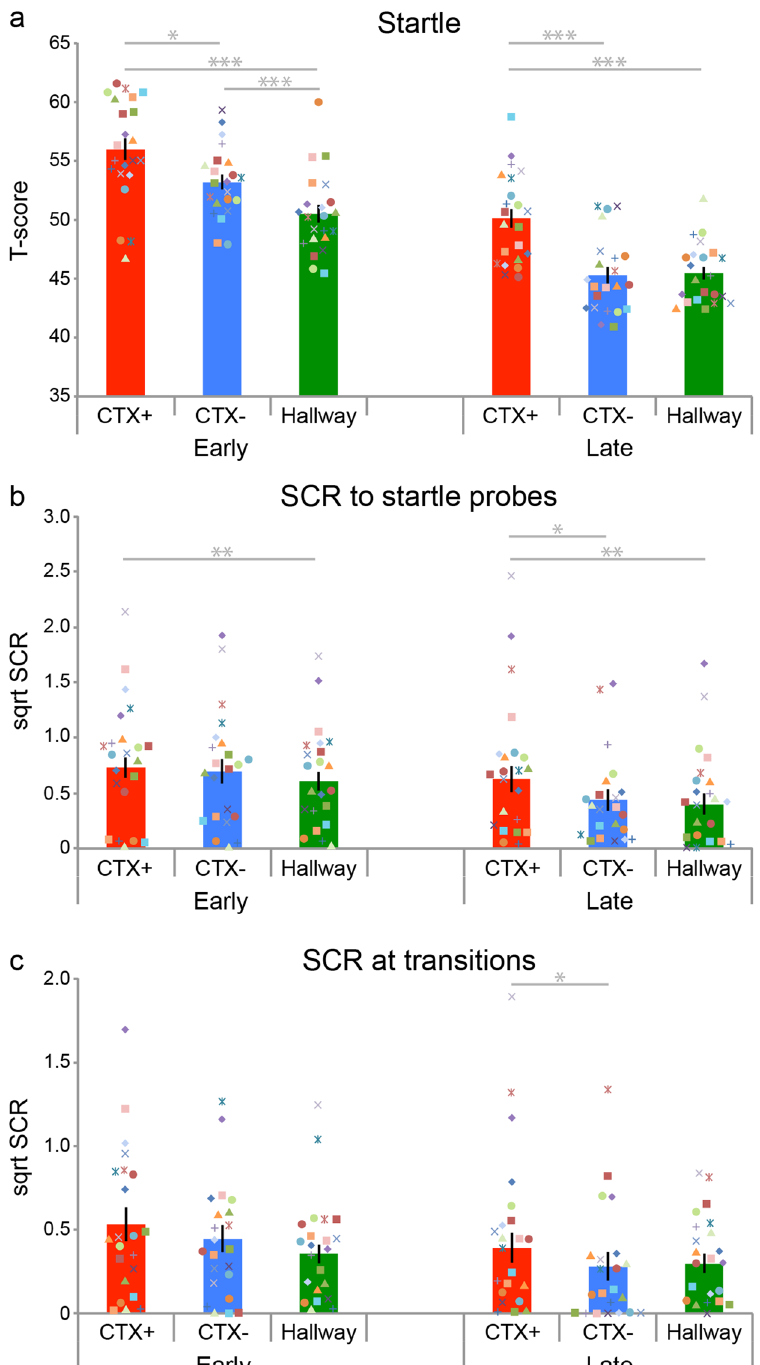
Figure 3. Context conditioning in iVR results in acquisition conditioned defensive responses. Bar plots reflecting mean startle and skin conductance responses in the first half (Early) and second half (Late) of the context-conditioning task for the threat (CTX + , red), safe context (CTX − , blue), and neutral context (Hallway, green). ( a ) Context conditioning resulted in greater electromyography responses (i.e. eye blink magnitude) to startle probes when participants traversed the threat context. ( b ) Context conditioning resulted in greater skin conductance responses (i.e. sweating) to startle probes when participants traversed the threat context. ( c ) Context conditioning resulted in greater skin conductance responses (i.e. sweating) when participants transitioned into the threat context. Error bars = s.e.m. Coloured geometrical shapes represent individual data- points. * p < 0.05, ** p < 0.01, *** p <